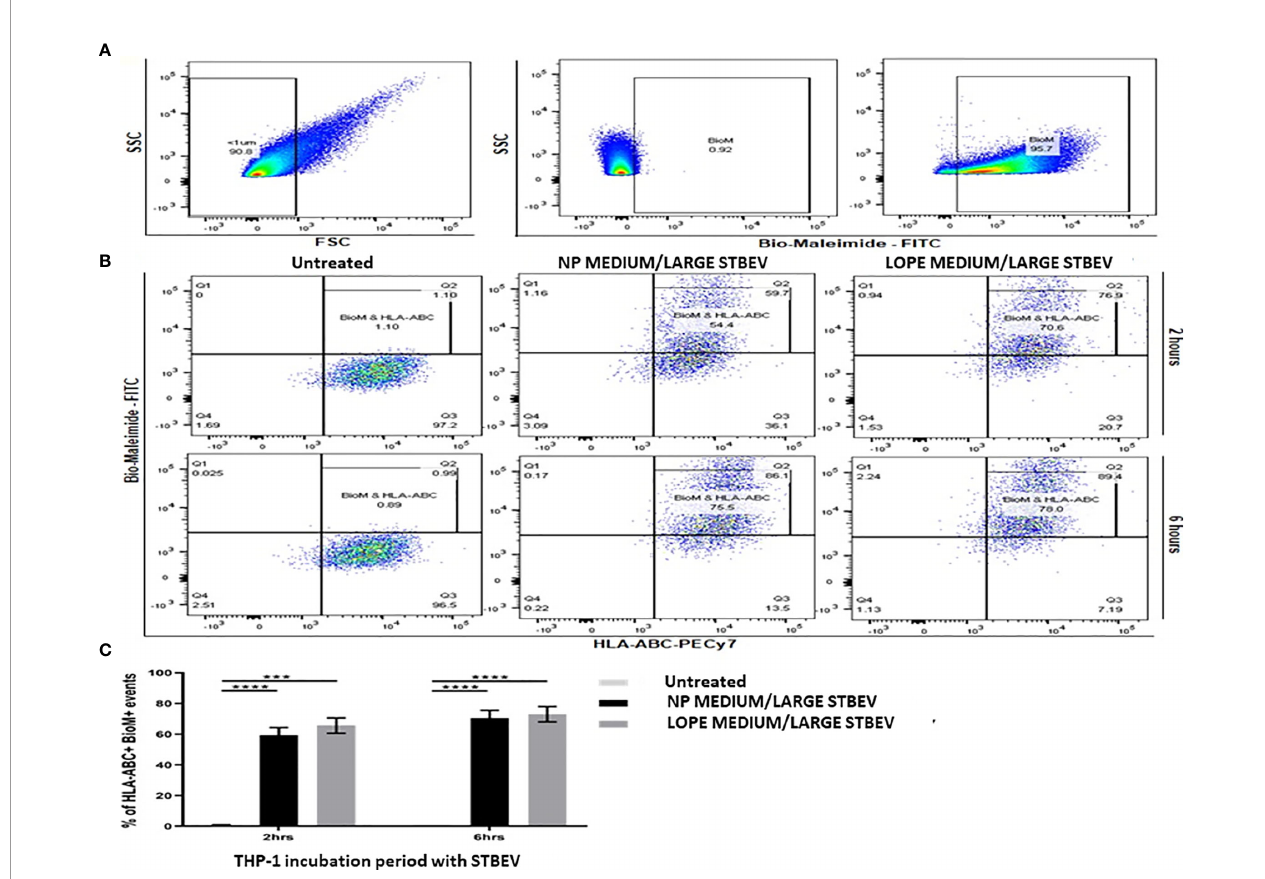
FIGURE 3 | Flow cytometry analysis of the uptake of medium/large STBEV derived from NP and PE placentae by differentiated THP-1 cells (n=3). Bio-Maleimide pre-stained medium/large STBEV characterisation (A) . Representative SSC vs FSC graph with chosen EV population to be less than 1 micron in size (characterised as microvesicles), followed by SSC vs Bio-Maleimide-FITC channel graph showing the chosen 1% cut-off gate using non-stained medium/large STBEV and Bio- Maleimide stained medium/large STBEV. Treatment of Bio-Maleimide stained medium/large STBEV to HLA-ABC stained THP-1 macrophages (B) . Representative Bio-Maleimide-FITC vs HLA-ABC-PeCy7 graph at 2 and 6 h treatment showing untreated THP-1, then treated ThP-1 with medium/large STBEV derived from NP and PE placentae. Bar-graph demonstrating merged results from THP-1 macrophages untreated and treated with NP and PE medium/large STBEV (C) plotted as HLA-ABC + Bio-Maleimide + against incubation period. Data presented as Mean ± SEM, signi fi cant difference shown as p<0.001 (***) and p<0.0001